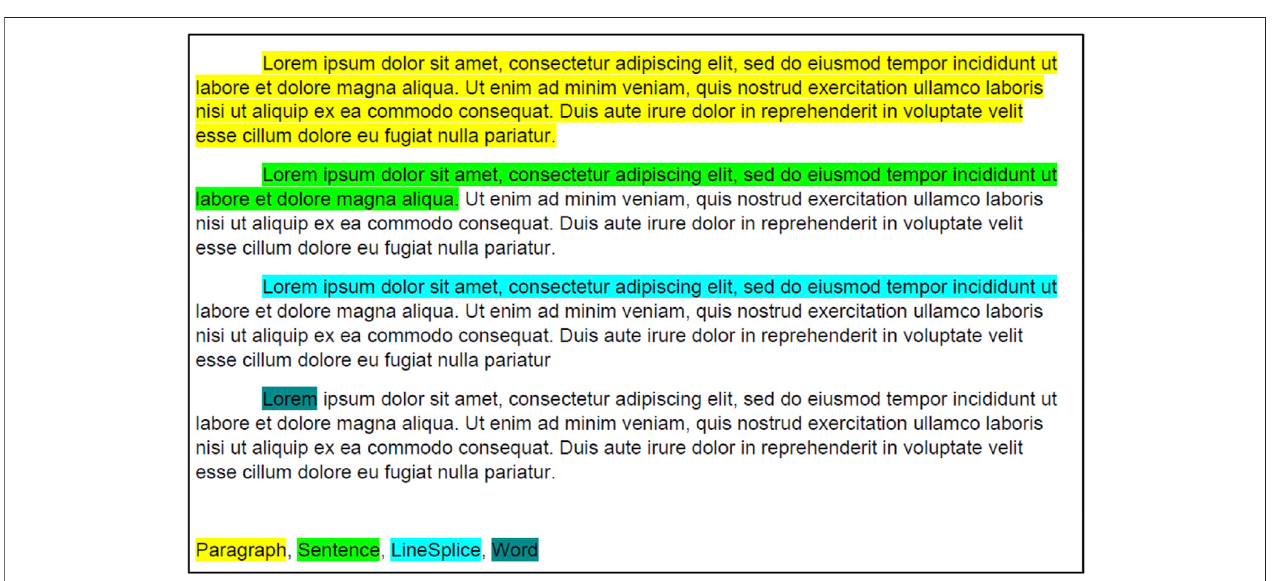
FIGURE 3 | PDFroggy — Data structure visual